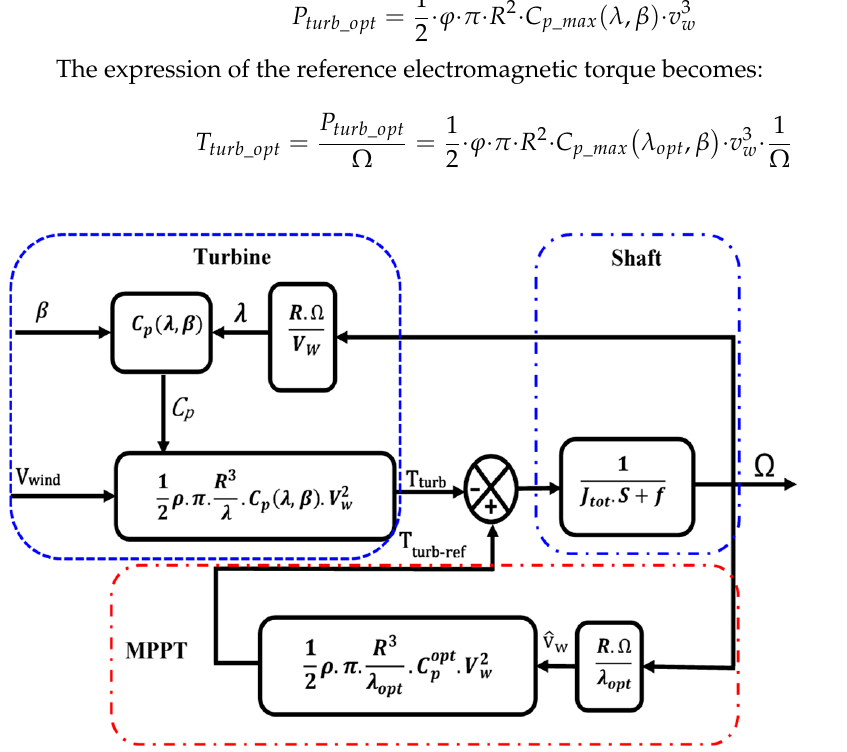
Figure 16. The MPPT strategy without speed measurement.